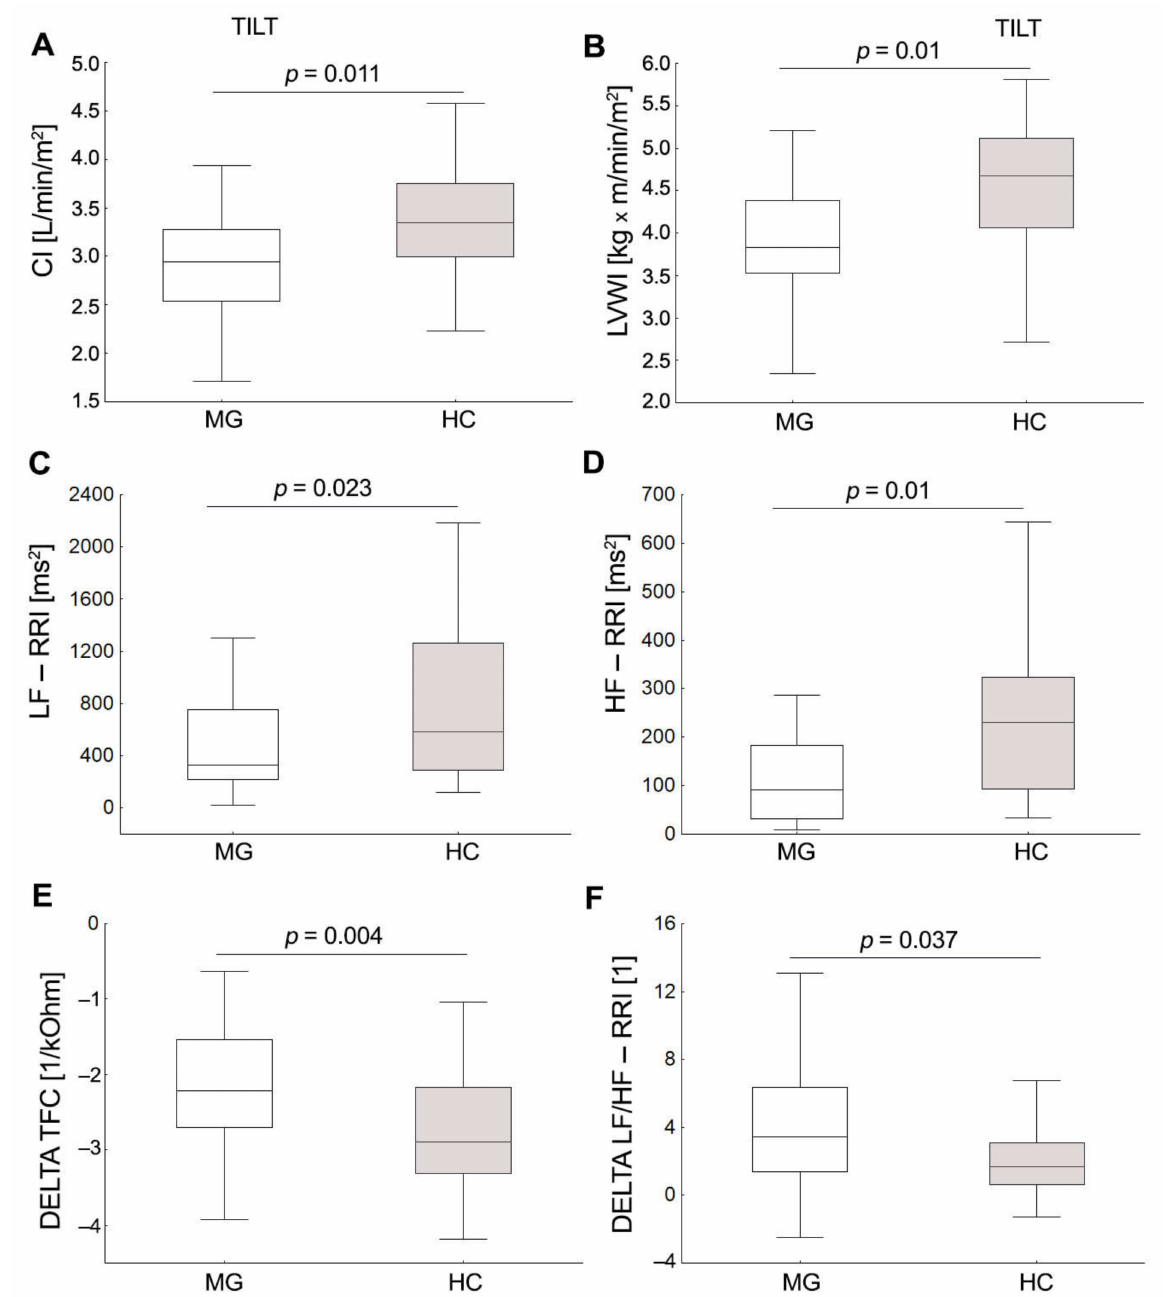
Figure 2. Scatter box plot showing the median, minimum and maximum values of CI, cardiac index ( A ); LVWI, left ventricular work index ( B ); LF-RRI, low frequency of heart rate variability ( C ); HF-RRI, high frequency of heart rate variability ( D ); TFC, thoracic fluid content ( E ); LF/HF-RRI, ratio between low and high band for heart rate variability ( F ) in MG group; respectively for compared to